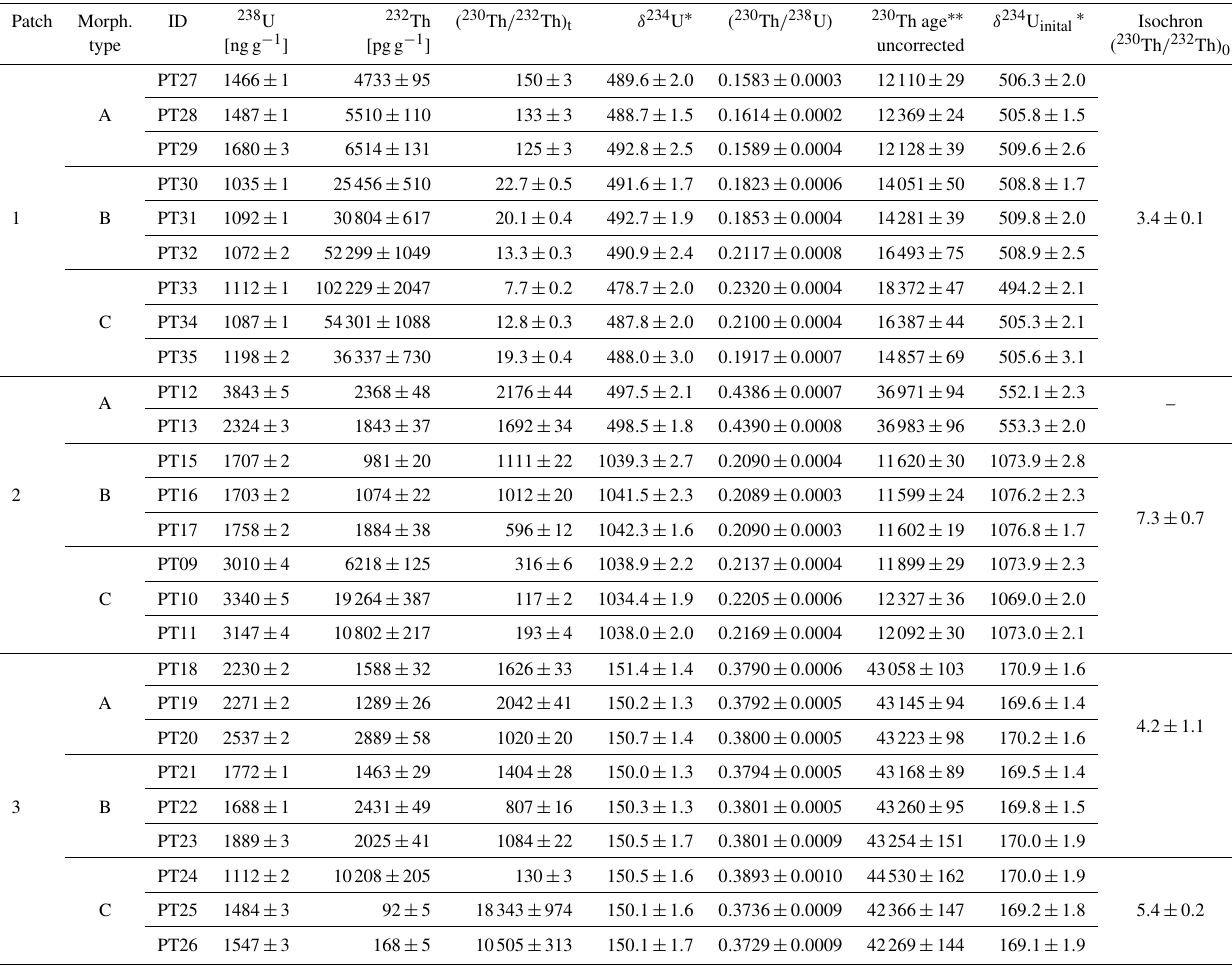
Table 1. Results of 230 Th / U analyses of CCC from Water Icicle Close Cavern. Uncertainties are reported at the 2 σ level. Patch